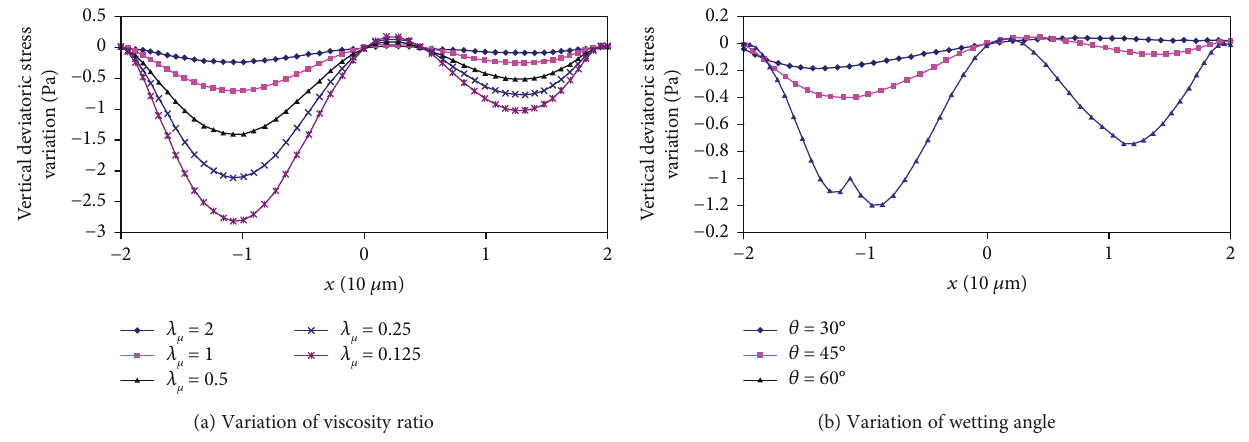
Figure 10: Curves of vertical deviatoric stress